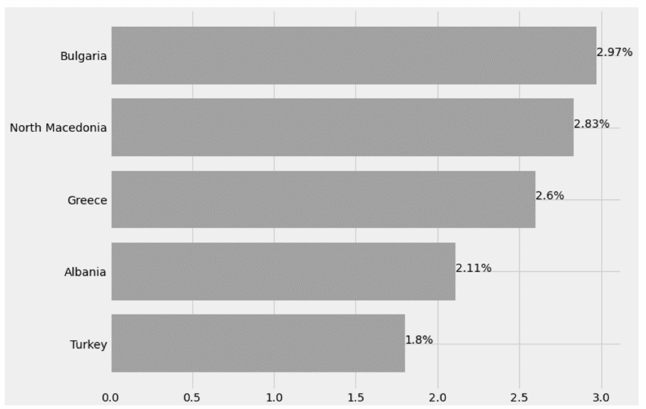
Figure 26. Mortality rate by